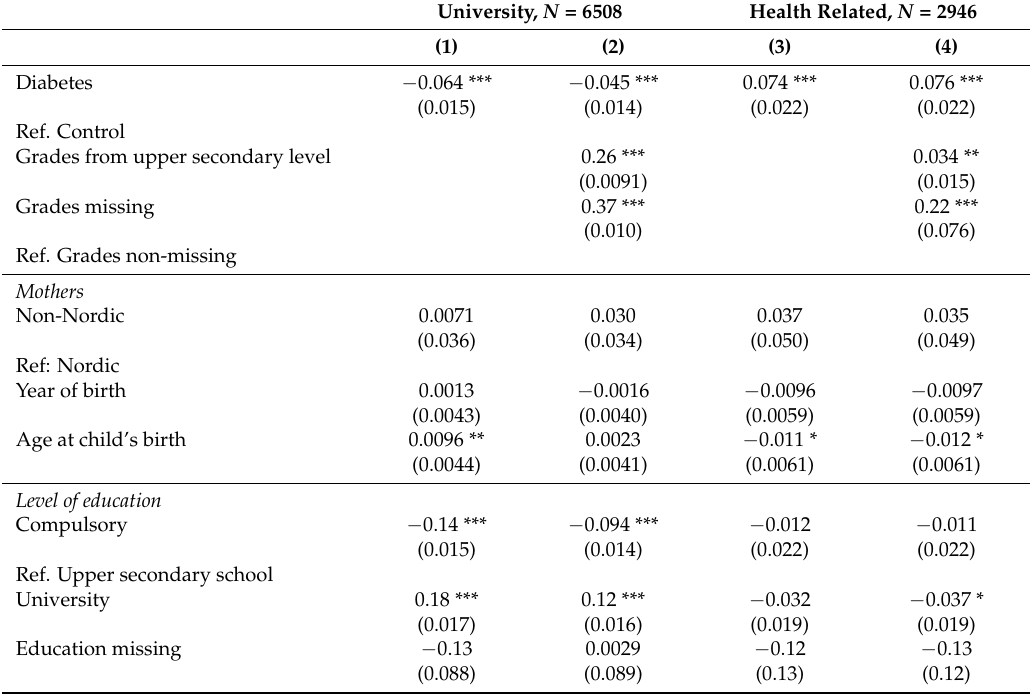
Table 5. Average marginal effects of women’s probability of having a university education and the probability of having a health-related university education for those with a university